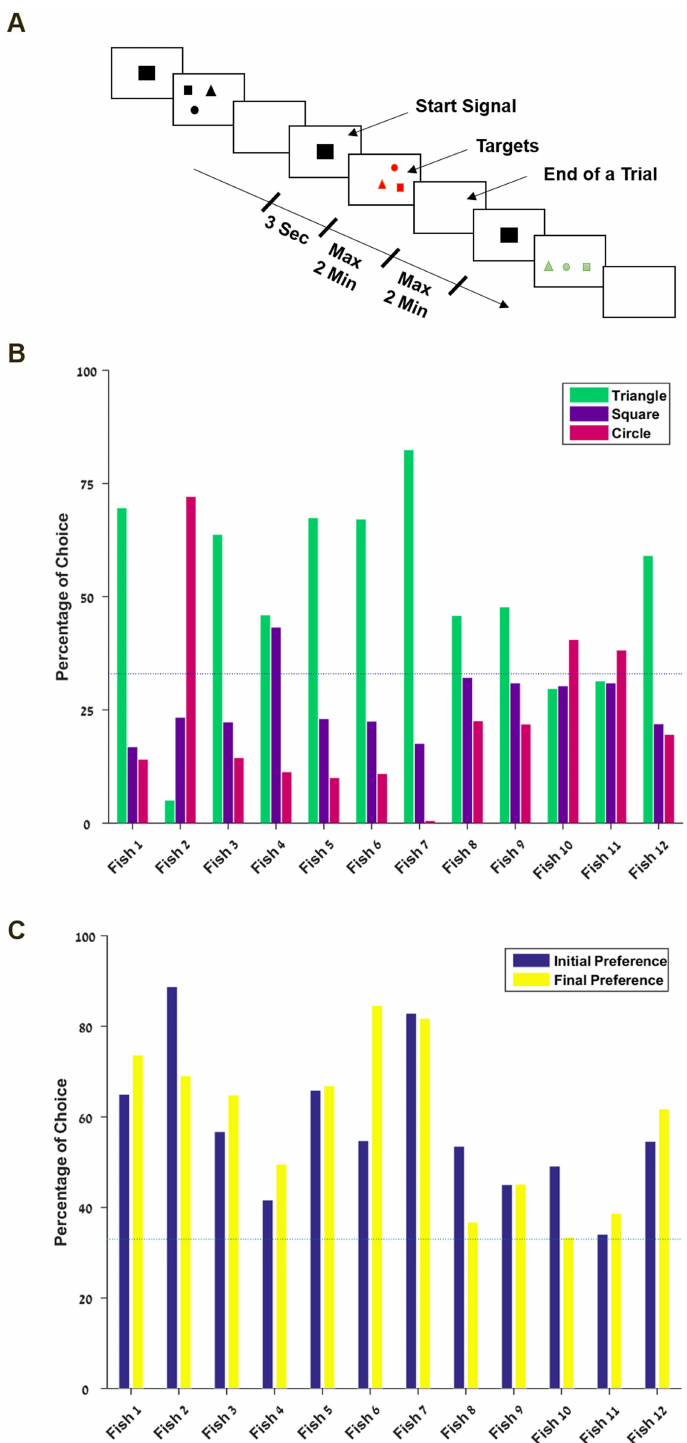
Fig 2. Fish show a varietyof natural preferences.A. Exampleof sequenceof stimuli presented during the determination of natural preference. B. Naturalpreferencefor shapes: percentage of choices for each target for the wholeexperiment. C. Stability of natural preference: averagenatural preference for the first and second half of the experiment. The dashedline represents the chance level (33%) .